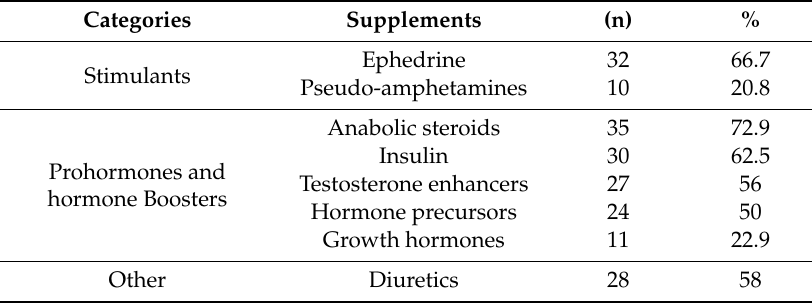
Table 3. Consumption of banned